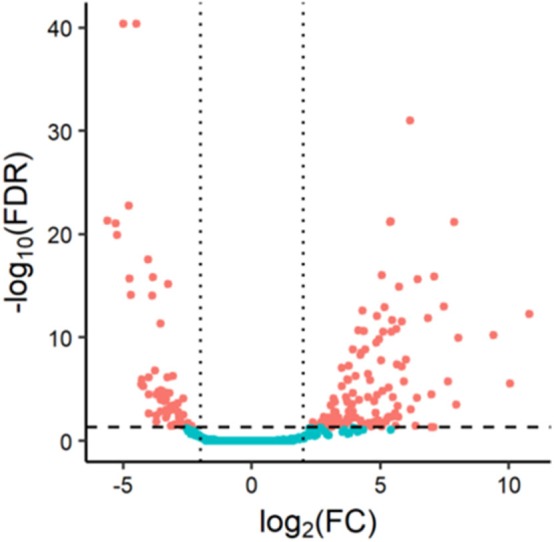
Volcano plot of 1,881 miRNAs in colon adenocarcinoma patients. Red color represents dysregulated expression.